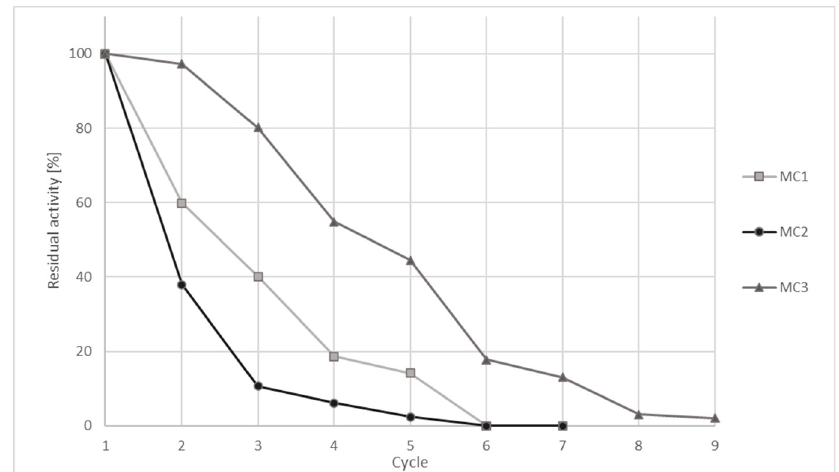
Figure 9. E ff ect of repeated use of immobilized ChOx on di ff erent chitosan functionalized metal oxide Figure 9. Effect of repeated use of immobilized ChOx on different chitosan functionalized metal oxide nanoparticles (MC1, MC2 and MC3) on enzyme nanoparticles (MC1, MC2 and MC3) on enzyme activity.